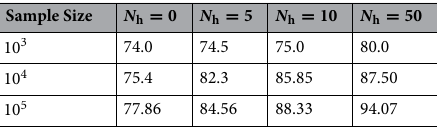
Table 1. Effect on accuracy with the increase of sample size.